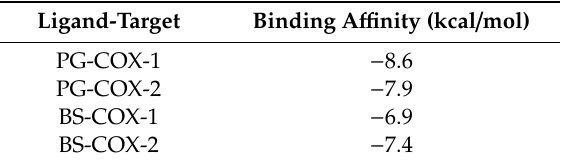
Table 3. Ligand-target binding affinity.